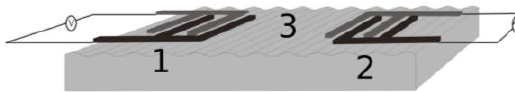
Figure 2. Typical set-up of a surface acoustic wave (SAW) biosensor: An acoustic wave propagates from a sender ( 1 ) to a receiver ( 2 ) passing the active sensor area ( 3 ) where its amplitude and velocity is influenced by the sensor surrounding ( i.e. , liquid or adsorbed mass). Adopted from [40].